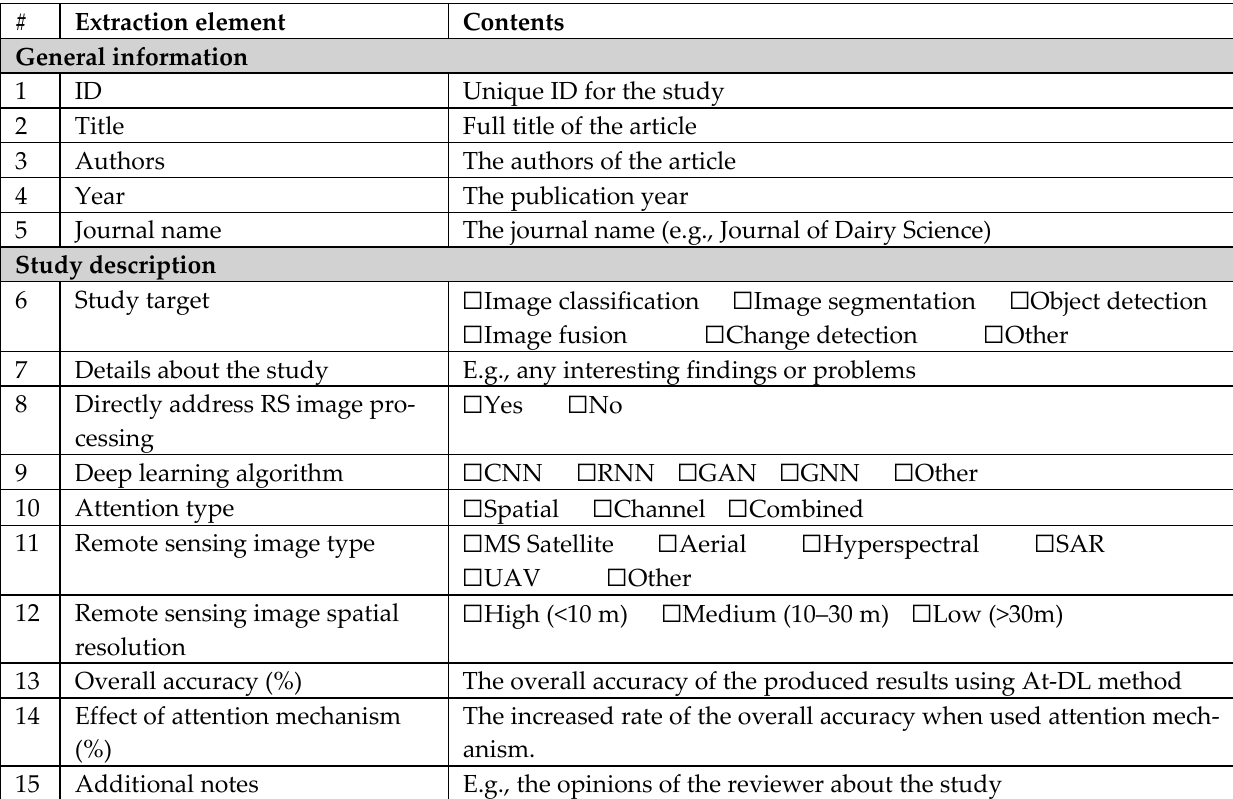
Table A1. Data extraction form.